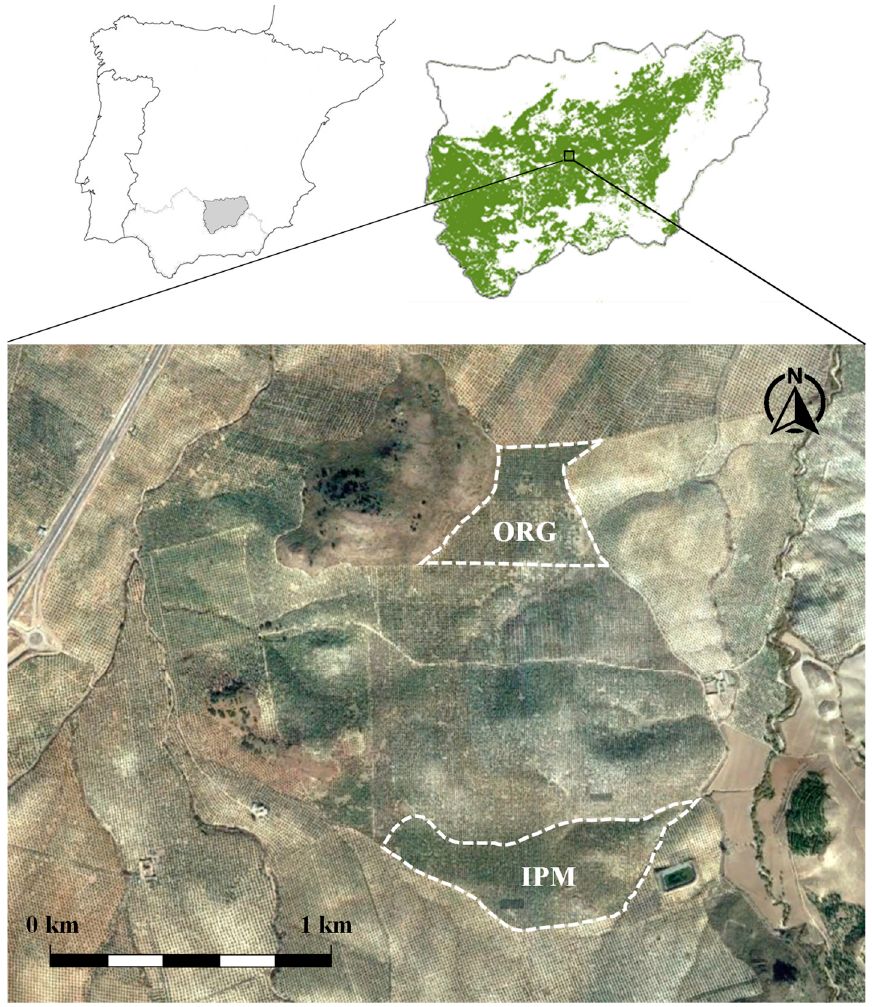
Figure 1. Location of the selected olive groves in the municipality of Jaén: Integrated pest management (IPM) and organic (ORG). Source: Own elaboration using the Google Earth Pro geographic information system.